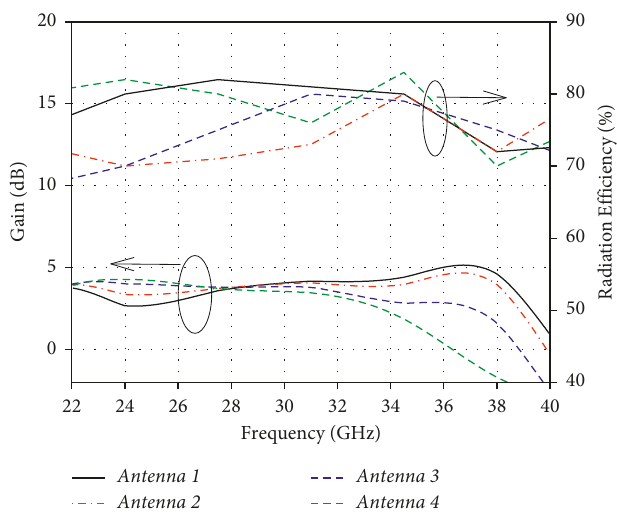
Figure 17: Measured gain and radiation efficiencies of antennas 1–4.